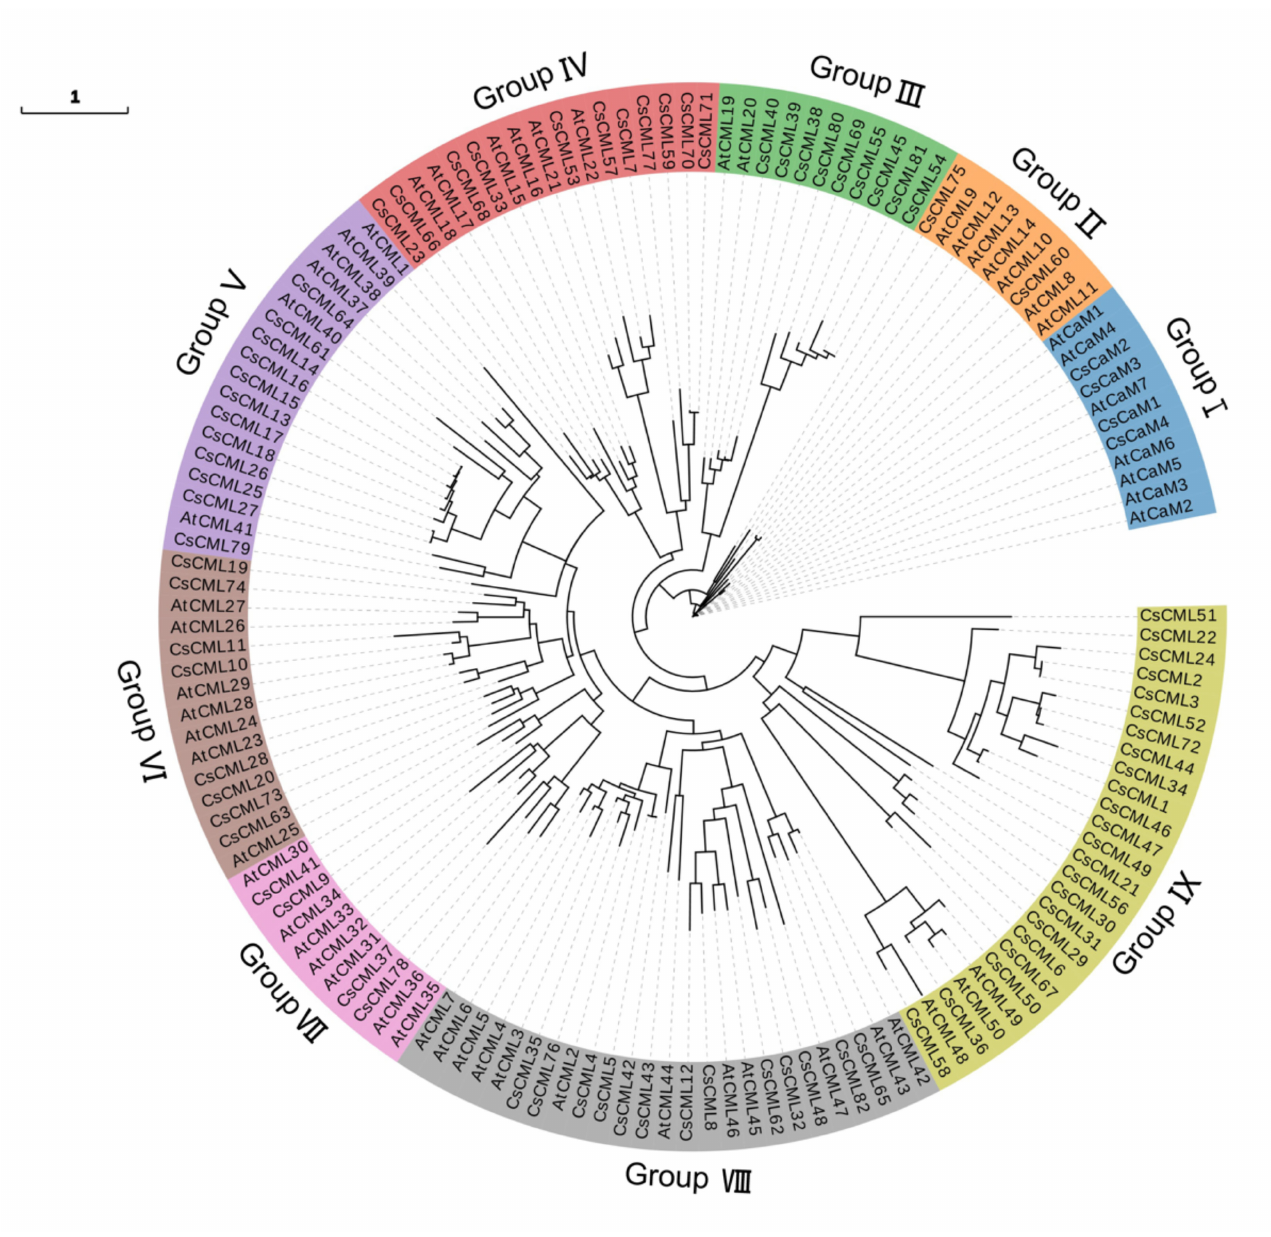
Figure 1. The phylogenetic tree of CsCaM/CML and AtCaM/CML. The phylogenetic analysis was constructed using FastTree with 57 CaM/CML in Arabidopsis thaliana and 86 CaM/CML in Chrysanthemum seticuspe ; different groups were